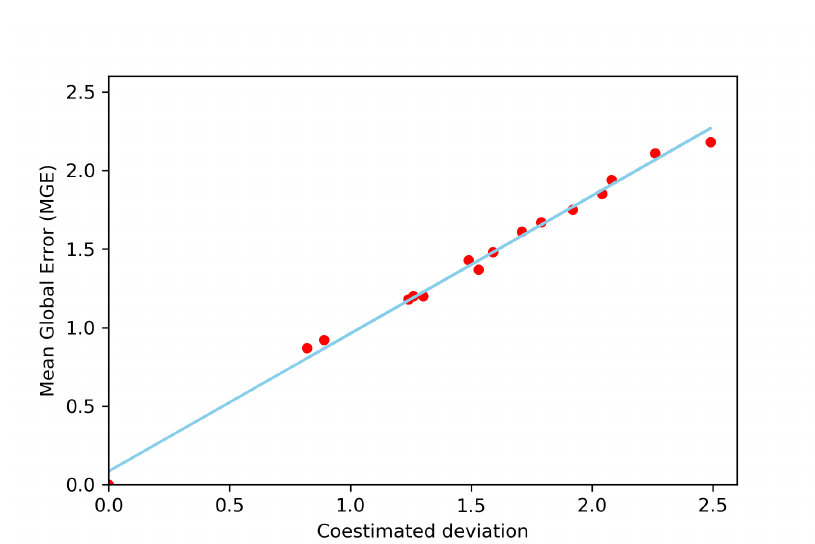
Figure 12. Relationship between the mean global error and the collocated ordinary cokriging deviation. and so on. For example, in the 13th scenario with a sampling density equivalent to 1% of the target population, the estimated mean is 10.02 and the deviation 1.24: µ COCK = 10.02 ± 1.24. This means that the estimated value could vary between 8.78 and 11.26. A similar value µ COCK = 10.02 ± 1.18 is obtained after correcting the deviation with the proposed function (10). Different parameters of the 15 scenarios are presented in Table